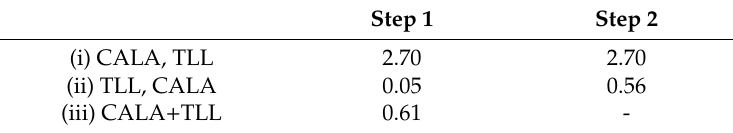
Table 3. EN measured by NMR for two-enzyme processes.